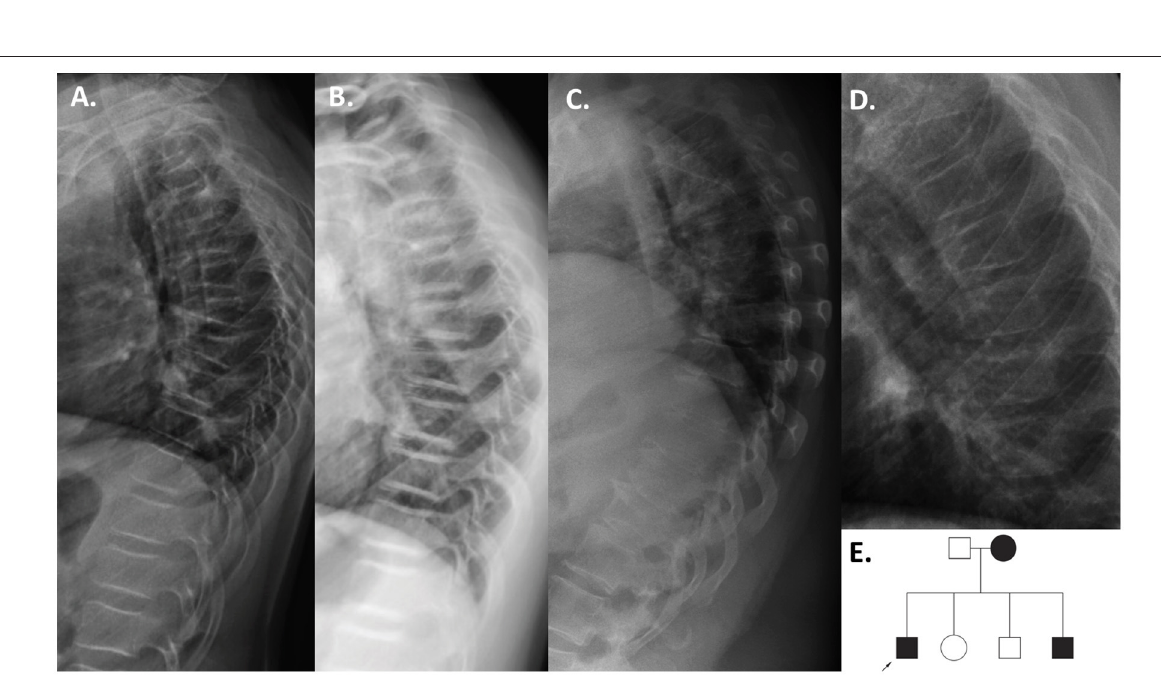
Frontiers in Endocrinology | www.frontiersin.org